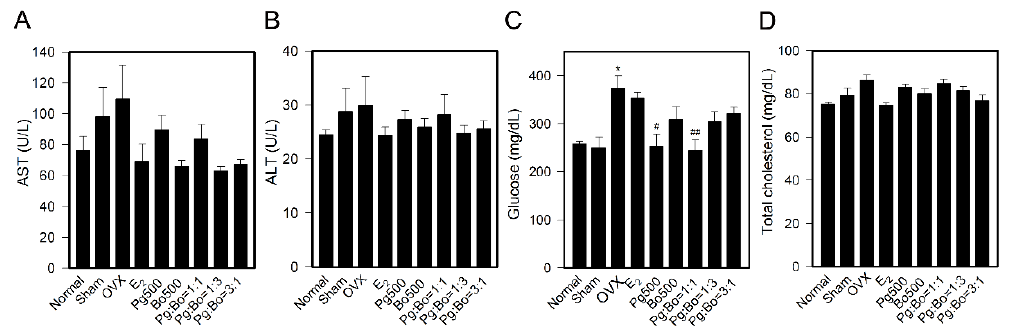
Figure 5. E ff ect of Pg and Bo on biochemical parameters in the OVX blood. ( A ), ( B ) Blood levels of liver enzymes aspartate aminotransferase (AST) and alanine aminotransferase (ALT), and glucose ( C ), and total cholesterol ( D ) were measured ( n = 6~10). All values are expressed as mean ± SEM. * p < 0.05 compared with Sham, # p < 0.05 and ## p < 0.01 compared with OVX.